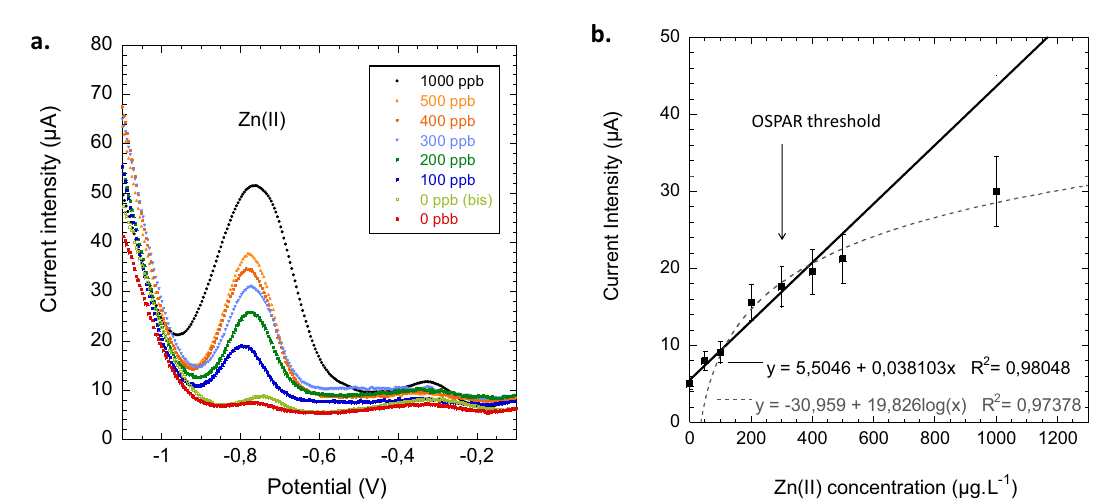
Figure 7. ( a ) SW-ASV voltammograms of Zn(II) obtained with PAA-g-PVDF nanoporous membrane- electrodes after a preconcentration step by adsorption of 30 min in standard Zn(II) water solutions and subsequent measurement in 0.1 M buffered acetate, pH 5; ( b ) Obtained calibration curve in the extended 1 concentration range of 10–1000 µ g L − (ppb) around OSPAR threshold for Zn in the case of production water from offshore petroleum